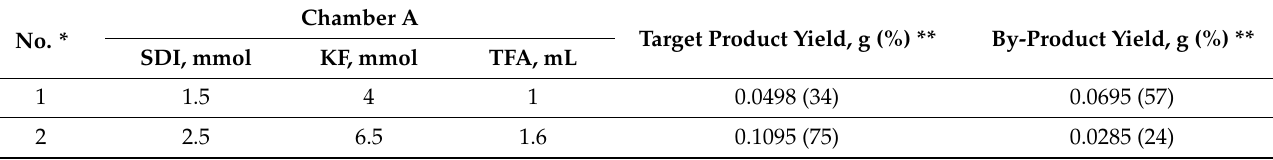
Table 1. Influence of excess SO 2 F 2 on the yields of the target compound and by-product of the SuFEx reaction. No. *